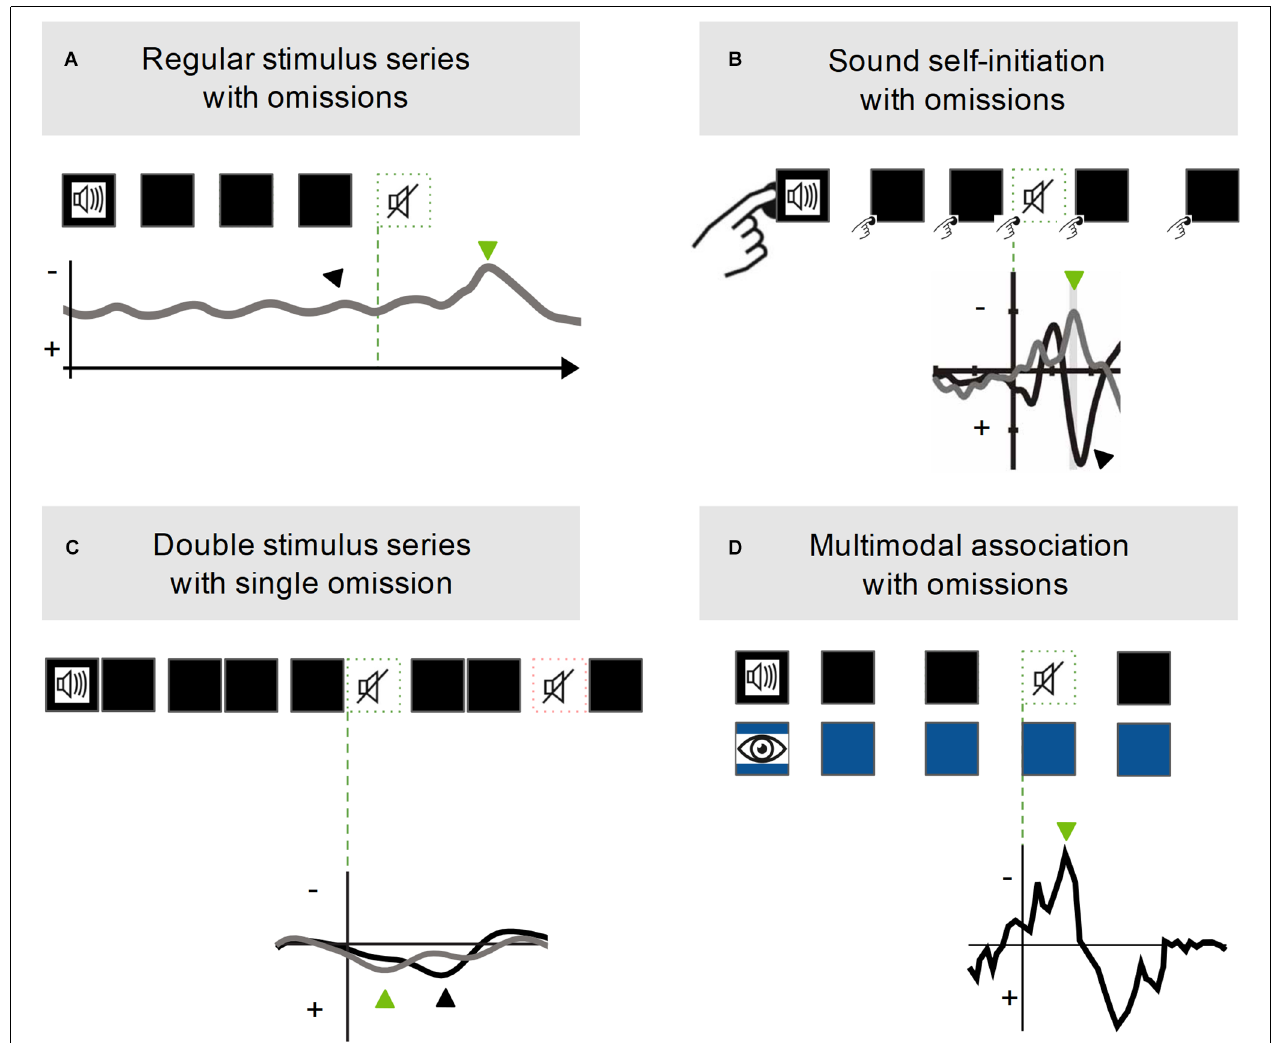
FIGURE 3 | Summary of omission response protocols and response examples. (A) The omission protocol consists of a series of auditory stimuli (black squares) presented at regular intervals. The omission response (green arrow) is observed at the end of the stimulus train, at a fixed latency from the onset of the expected but missing stimulus (green dashed square). Adapted from Andreou et al. (2015). (B) The button-pressing symbol indicates that the auditory stimuli are self-initiated. This protocol consists of self-paced button pressing to which a stimulus is associated but randomly withheld. The omission response is observed when the action is performed but the action-associated stimulus is withheld. The black arrow indicates the response to the standard self-initiated stimulus. Adapted from SanMiguel et al. (2013a). (C) The orange dashed square indicates the omission of the first stimulus in a pair. This protocol consists of a series of stimulus pairs of which the first or second stimulus is randomly omitted. The omission response is observed when the second stimulus of the pair is omitted. Adapted from Bendixen et al. (2009). (D) The blue squares represent visual stimuli. This protocol consists of a series of paired presentations of a visual stimulus and an auditory stimulus, in which the auditory stimulus is randomly omitted. The omission response is observed in auditory areas when the auditory stimulus is omitted. Adapted from Stekelenburg and Vroomen